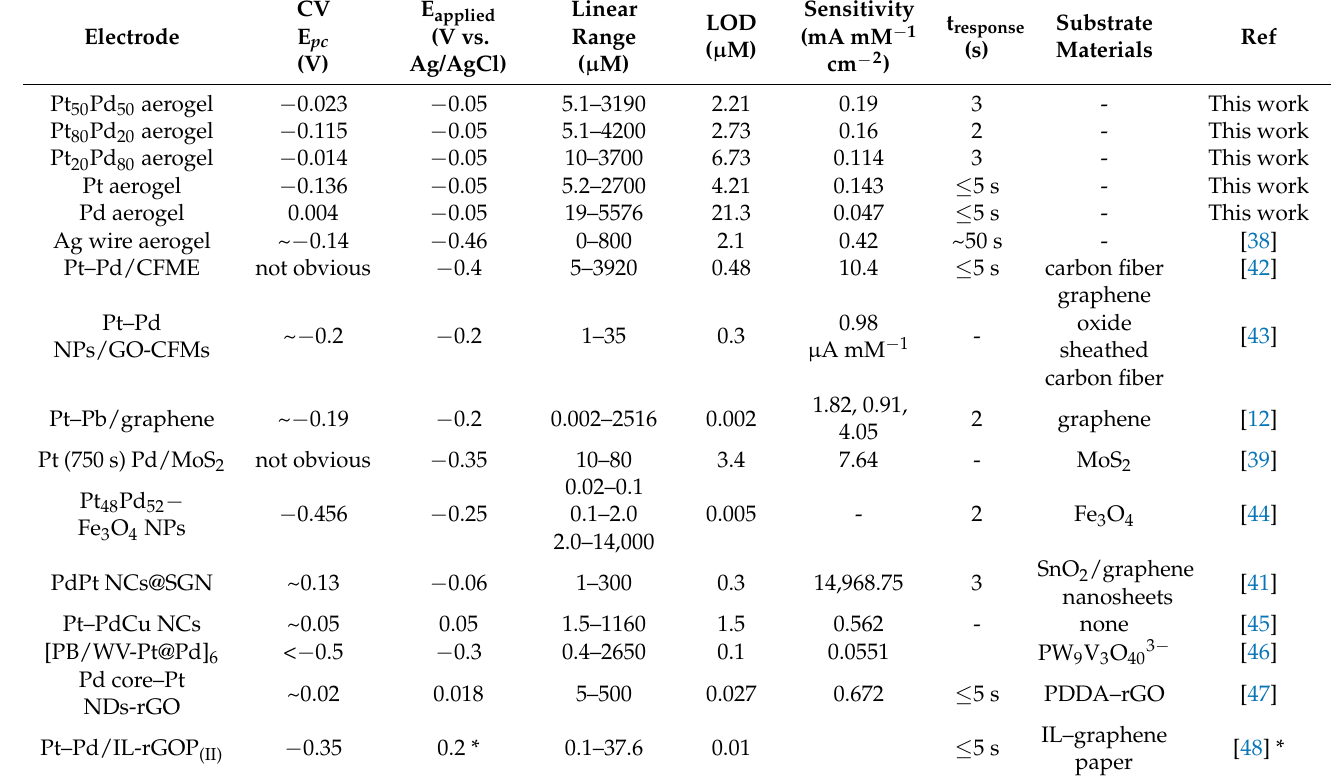
Table 2. Summary of the performances of the nonenzymatic H 2 O 2 electrochemical sensors based on aerogel materials and Pt and Pd elements containing bimetallic